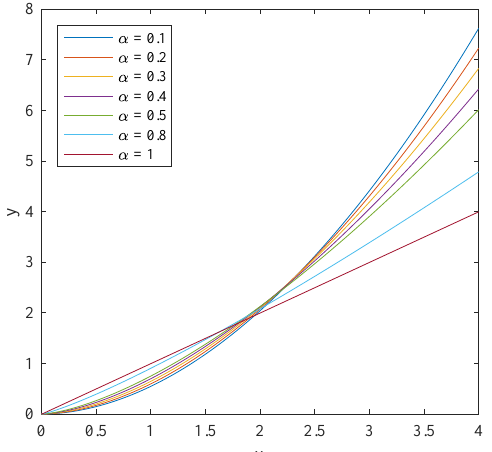
x 2 for different orders α 2